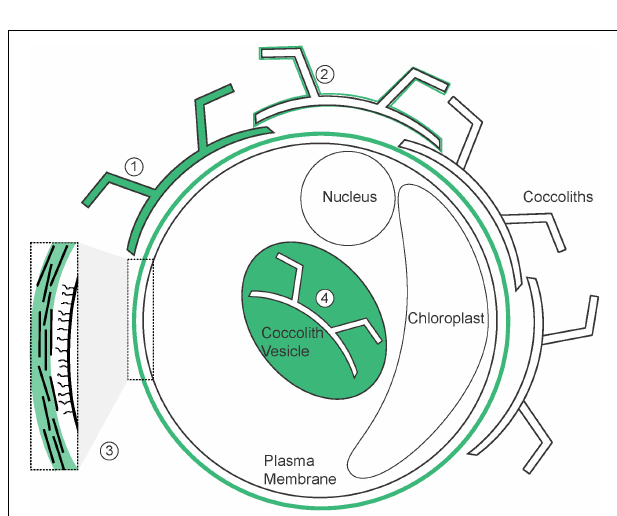
FIGURE 8 | Potential localization of CAPs. Schematic illustration of a coccolithophore cell (based on C. braarudii ) demonstrating the localization of CAPs identified both in previous research and in this study (highlighted in green). (1) Intracoccolith; (2) coccolith surface; (3) organic layer; (4) coccolith vesicle. Inset shows details of the components of the organic layer; including amorphous polysaccharide (green), organic scales and fibrillar material.